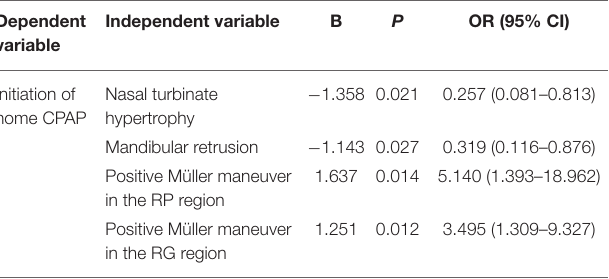
TABLE 4 | Association between UA characteristics and the initiation of home CPAP treatment in the regression model. Dependent Independent variable